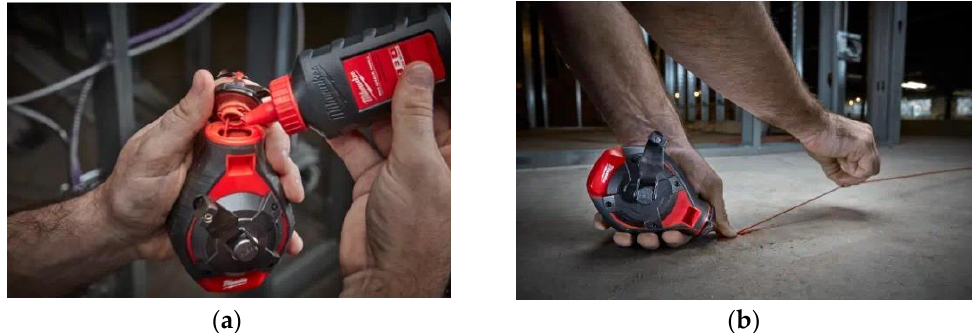
Figure 1. Conventional manual layout-printing work process example: ( a ) filling with powder and ( b ) snapping a chalk line.